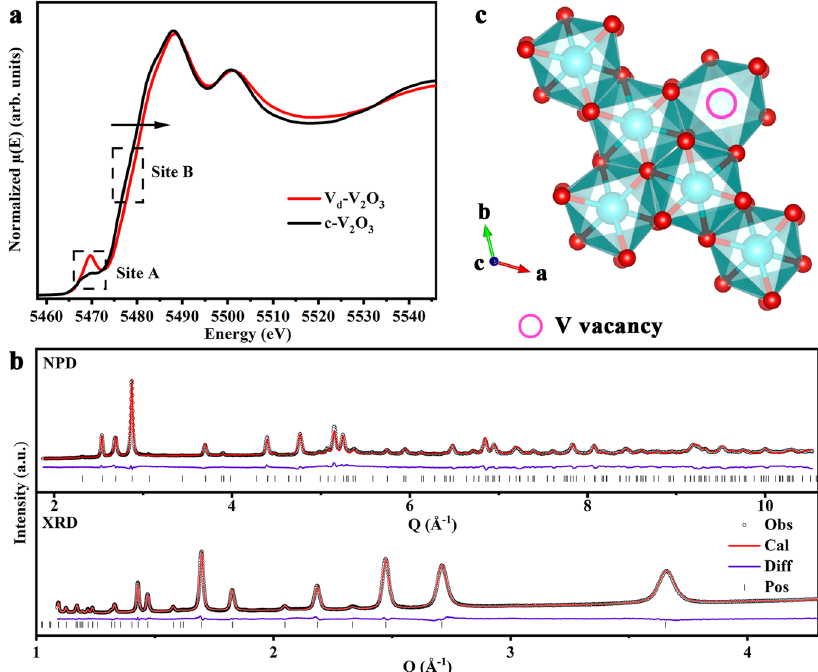
Fig. 2 Structural characterization of V d – V 2 O 3 . a Normalized XANES spectra of V K-edge for V d – V 2 O 3 and c-V 2 O 3 . b Observed (black circle), calculated diffraction patterns (red line), their difference (purple line) and peak position (black bar) of the NPD pattern (upper part) and XRD pattern (lower part). c Schematic diagram of the structure of V d – V 2 O 3 along the c-axis. The oxygen atoms are represented by small red spheres, and the V atoms are depicted in blue.